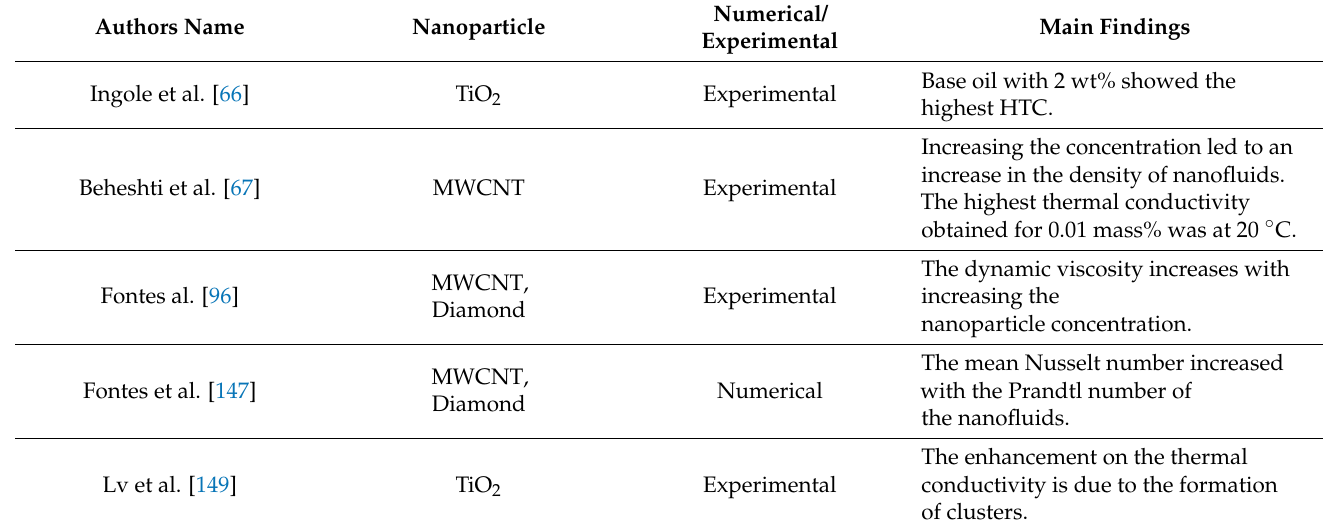
Table 12. Comparison of previous investigations on mineral-oil-based